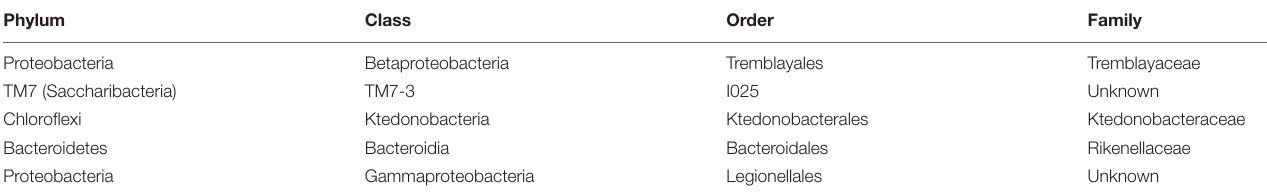
FIGURE 4 | Representative genera that varied in relative abundance in soils with Yersinia relative to soils without Yersinia . TABLE 1 | Classification of bacterial families found at significantly higher abundance in soil samples containing Yersinia